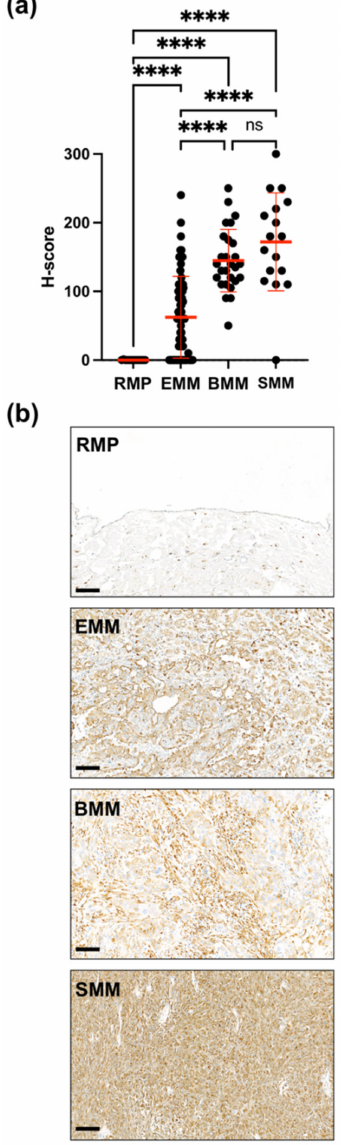
Figure 3. IHC analysis of uPARAP expression in TMAs from MM and RMP. ( a ) The graph indicates H-scores obtained by uPARAP IHC analysis of cores representing RMP ( n = 13), EMM ( n = 73), BMM ( n = 27) and SMM ( n = 17). Data are shown as mean ± SD for the individual MM subtypes and RMPs. Welch’s ANOVA test was used for the comparison of the groups. **** ( p ≤ 0.0001). ( b ) Representative examples of uPARAP staining in TMA cores from RMP (no staining in the mesothelium and fibrotic stroma, except for scattered stained macrophages), EMM, BMM, and SMM tissue (all three showing diffuse positive uPARAP expression). Note the stronger stain of the sarcomatoid vs. epithelioid tumor cells in the BMM example. Scale bars: 100 µ